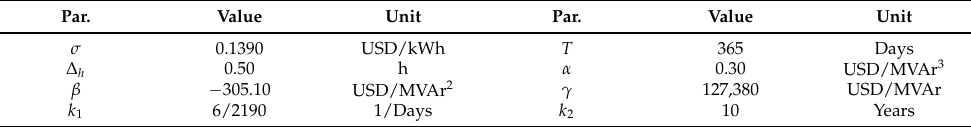
Table 3. Parameter data to calculate the annual investment costs of D-STATCOMs.